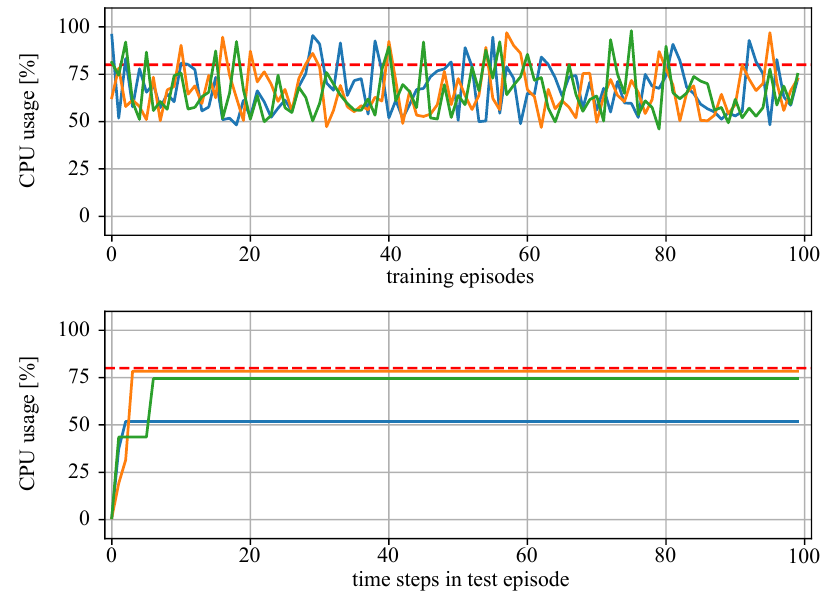
Figure 10. Results of the training and test of MAS1 with three agents (green, blue, orange lines: CPU usage of agent devices; red dotted line: threshold 80%). Above: CPU usage at the end of each training episode. Below: CPU usage at each time step of a single test